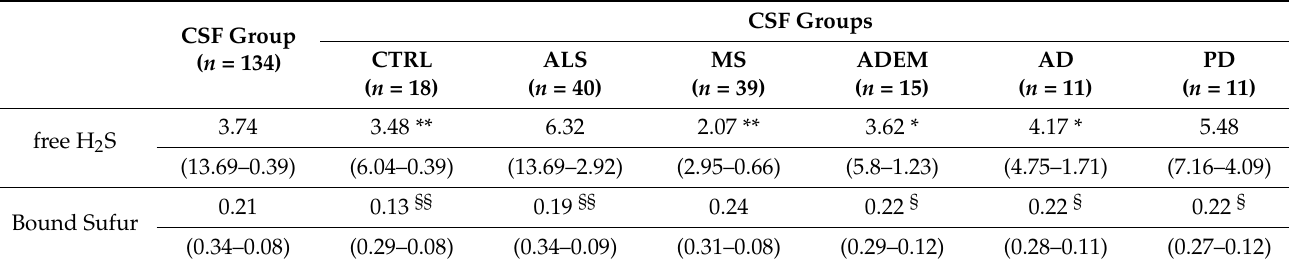
Table 4. H 2 S measurements across the CSF population. Data were analyzed with the Mann–Whitney test; values (mg/L) are presented as median, with ranges in